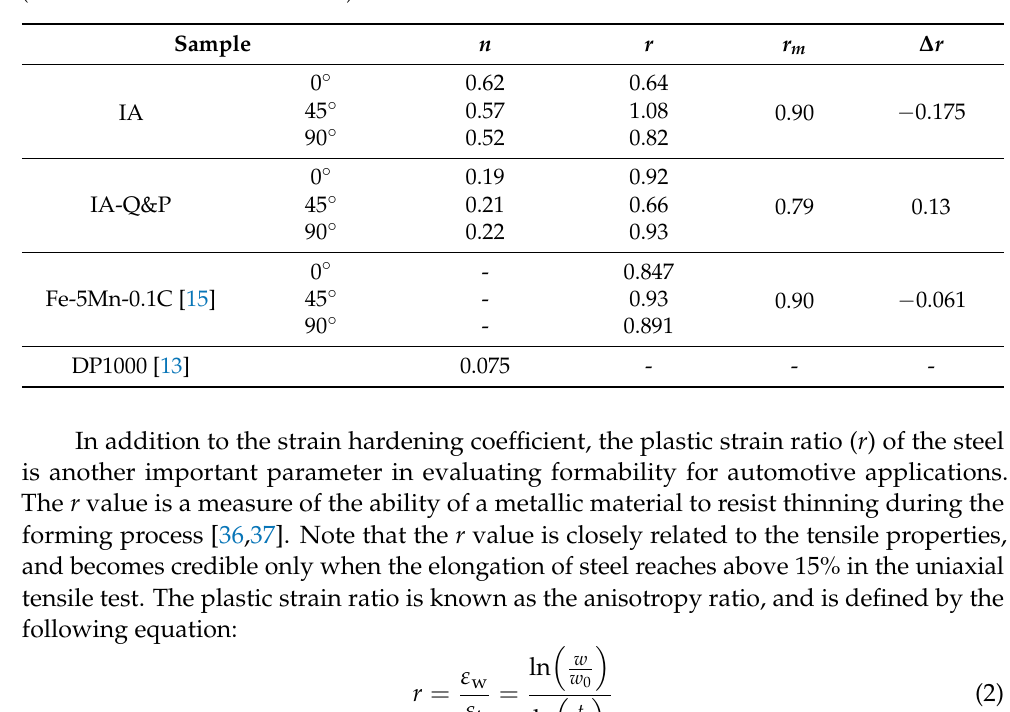
Table 2. The n , r , r m , and ∆ r values of IA and IA-Q&P steel compared to other high-strength steels. (“-“ means no value in